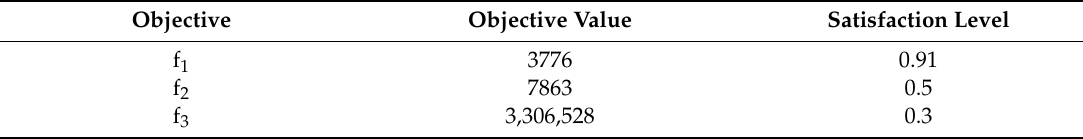
Table 6. The objective values and the satisfaction